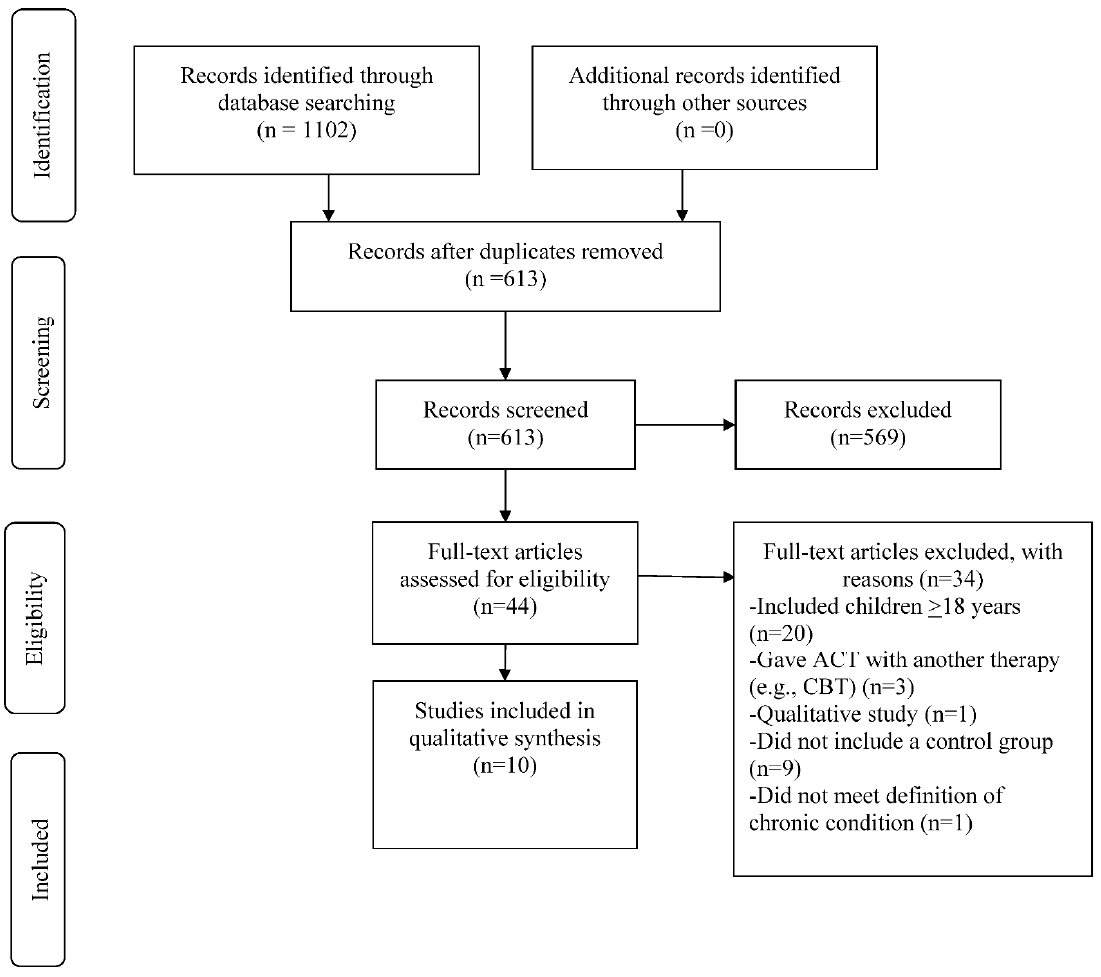
Figure 2. PRISMA Flow Diagram of Study Selection.